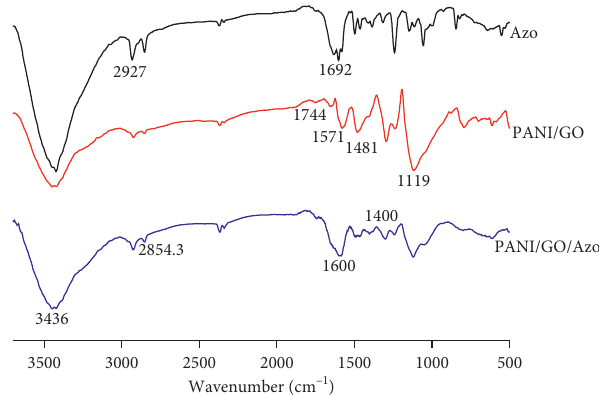
Figure 4: FT-IR spectra of Azo, PANI/GO, and PANI/GO/Azo.